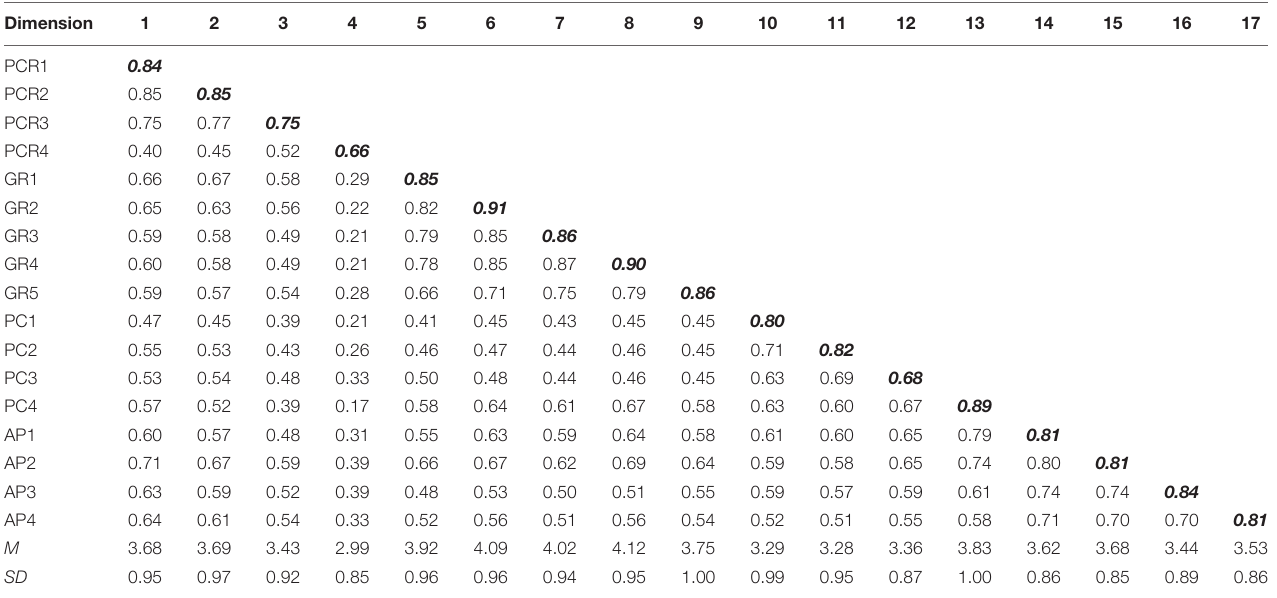
TABLE 6 | Descriptive statistics, correlation analysis and discriminant validity. Dimension